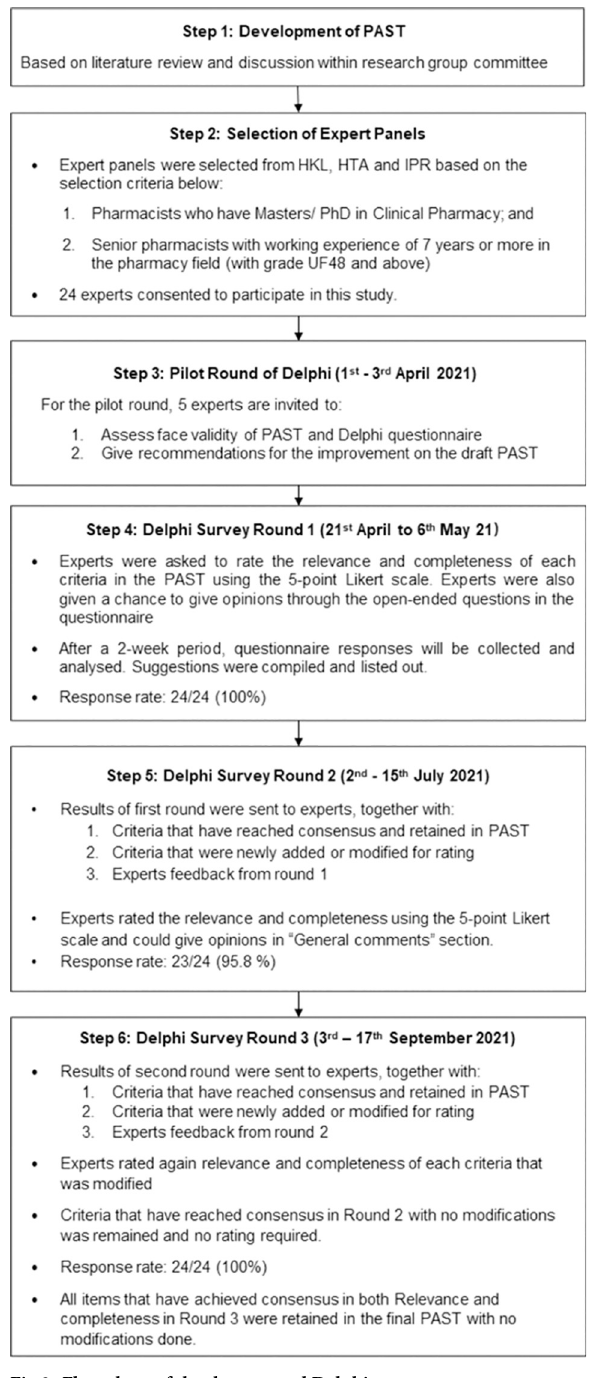
Fig 2. Flow chart of the three-round Delphi